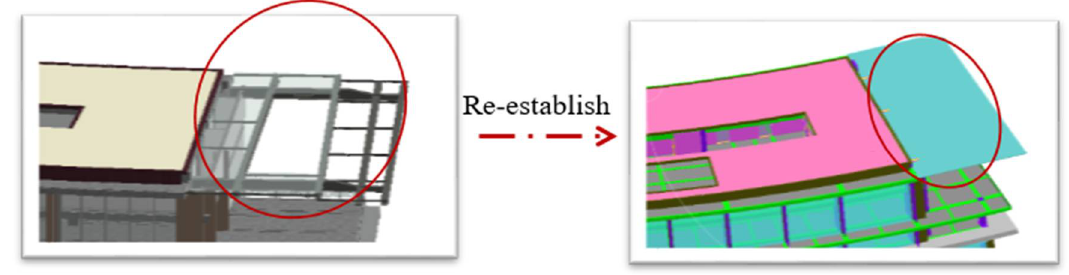
Figure 11. Example of a missing canopy and the need for solving the missing element.